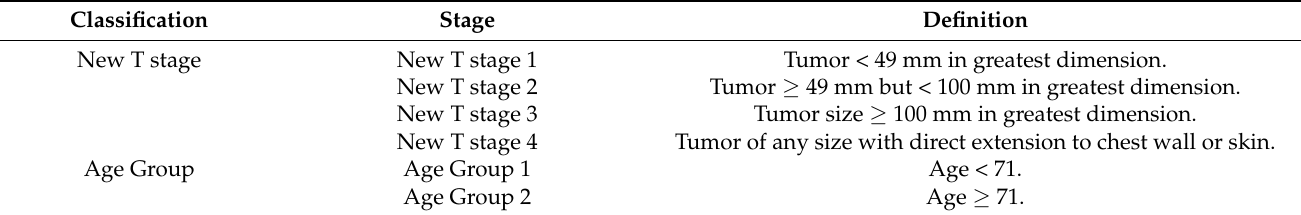
Table 3. New staging system for patients with malignant phyllodes tumor.